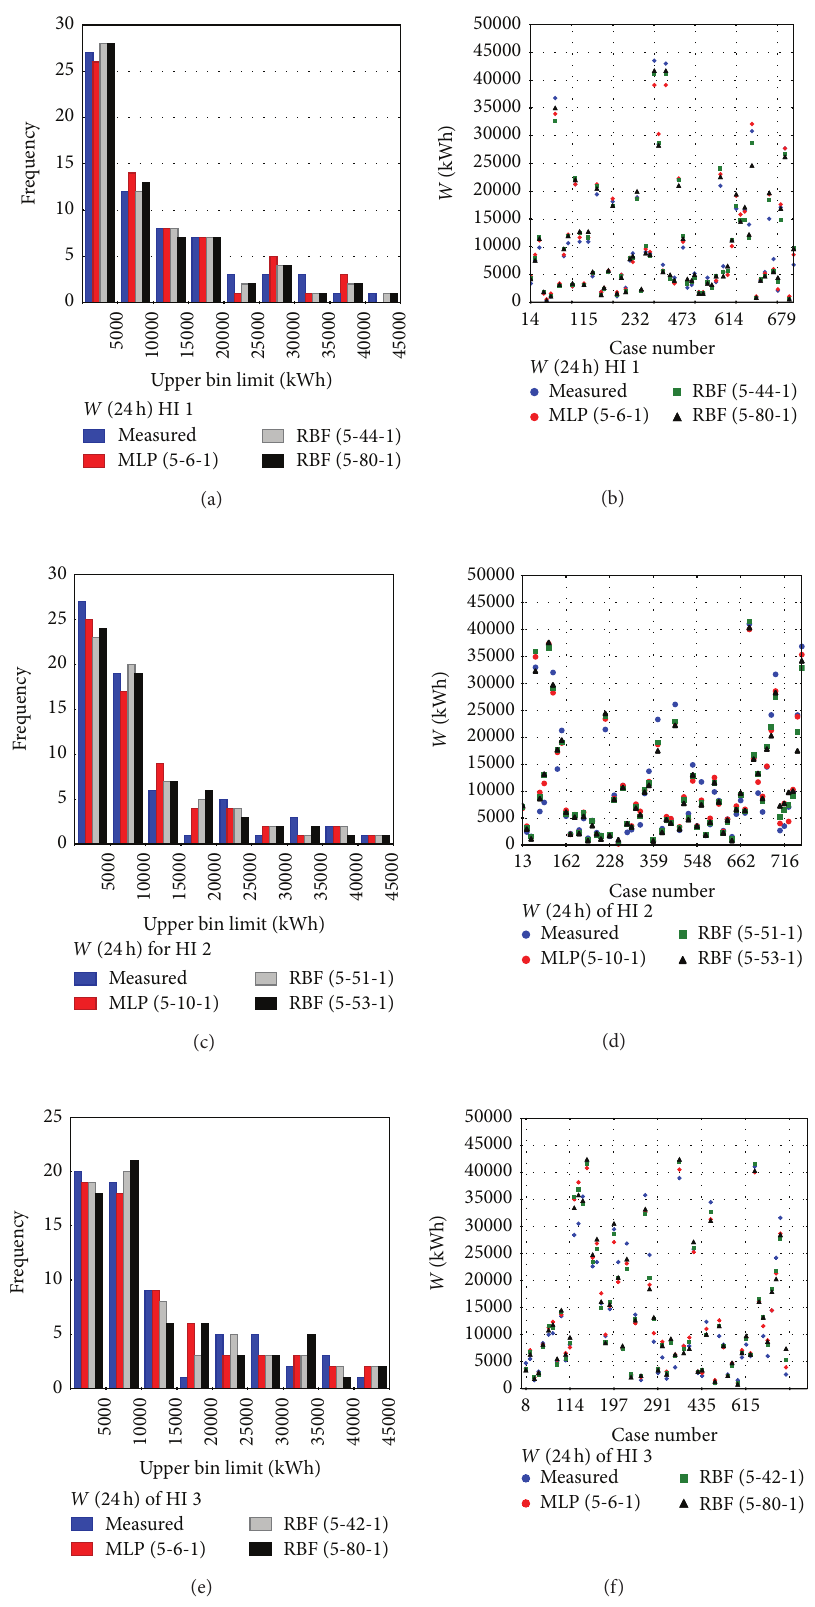
Figure 3: Results for the 3 best networks for the dataset of the coastal wind farms Hinte and Jennelt . The case numbers in the right panels represent individual data records of the complete time series available that were chosen randomly and assigned to the validation